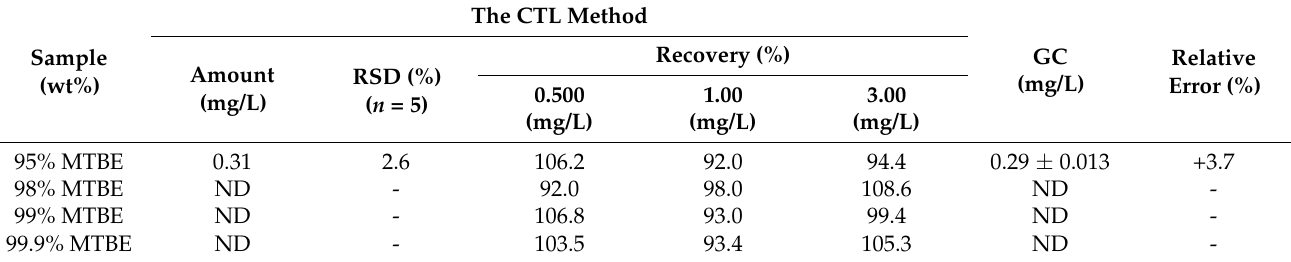
Table 1. Detection and recovery of MSBE in MTBE